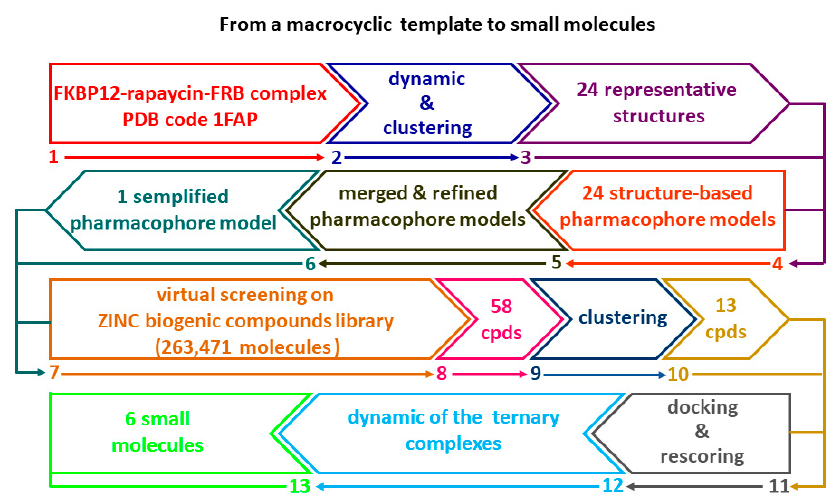
Figure 1. Flowchart illustrating the multistep computational method.